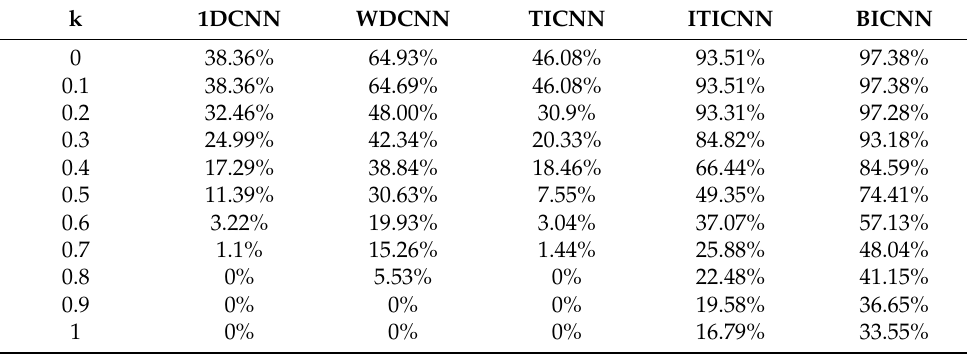
Table 6. Integrated diagnosis accuracy of five convolutional neural